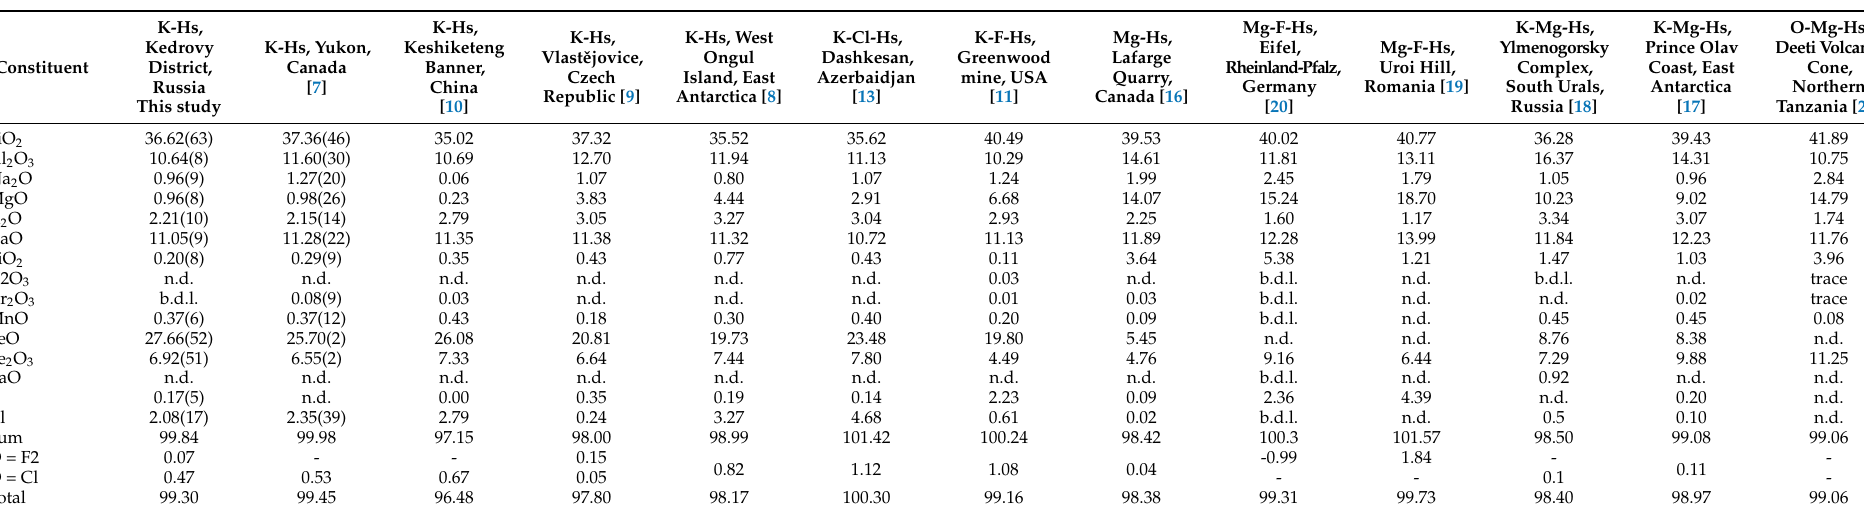
Table 4. Combined EPMA and XRF data of studied potassic-hastingsite. For comparison purpose, reference data are reported. Hs—hastingsite. n.d.—not determined, b.d.l.—below detection limit.